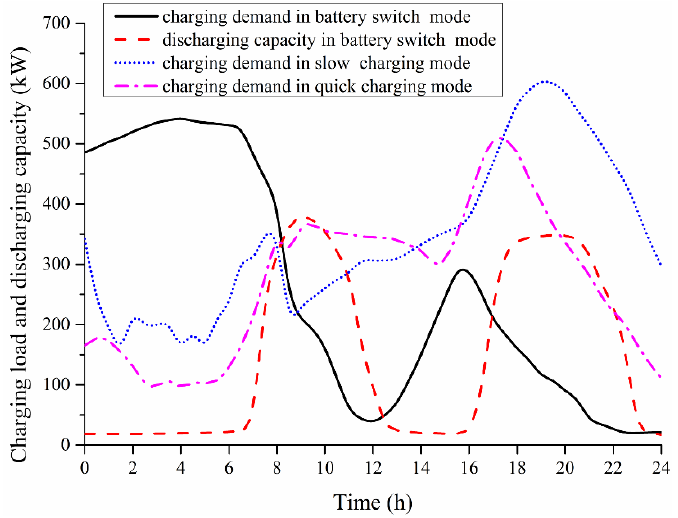
Figure 10. The charging load and discharging capacity in three recharging modes.